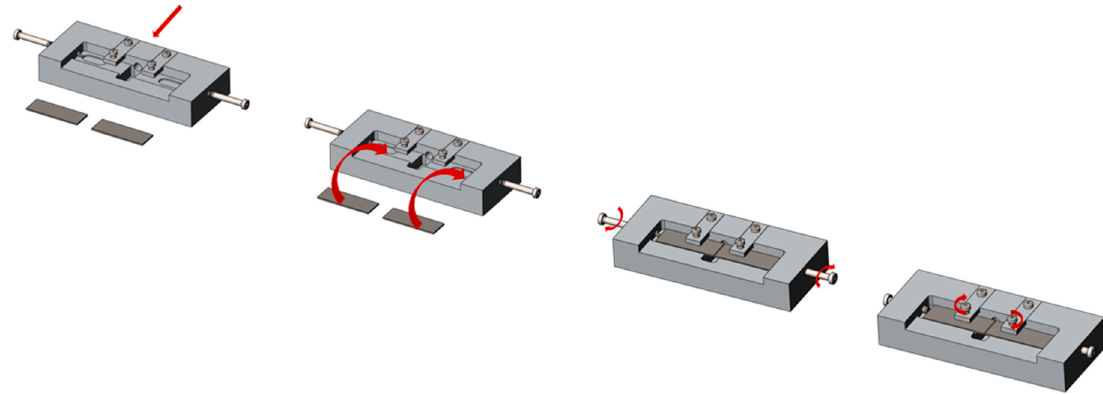
Figure 2. Illustration of the support/fixation system operation.